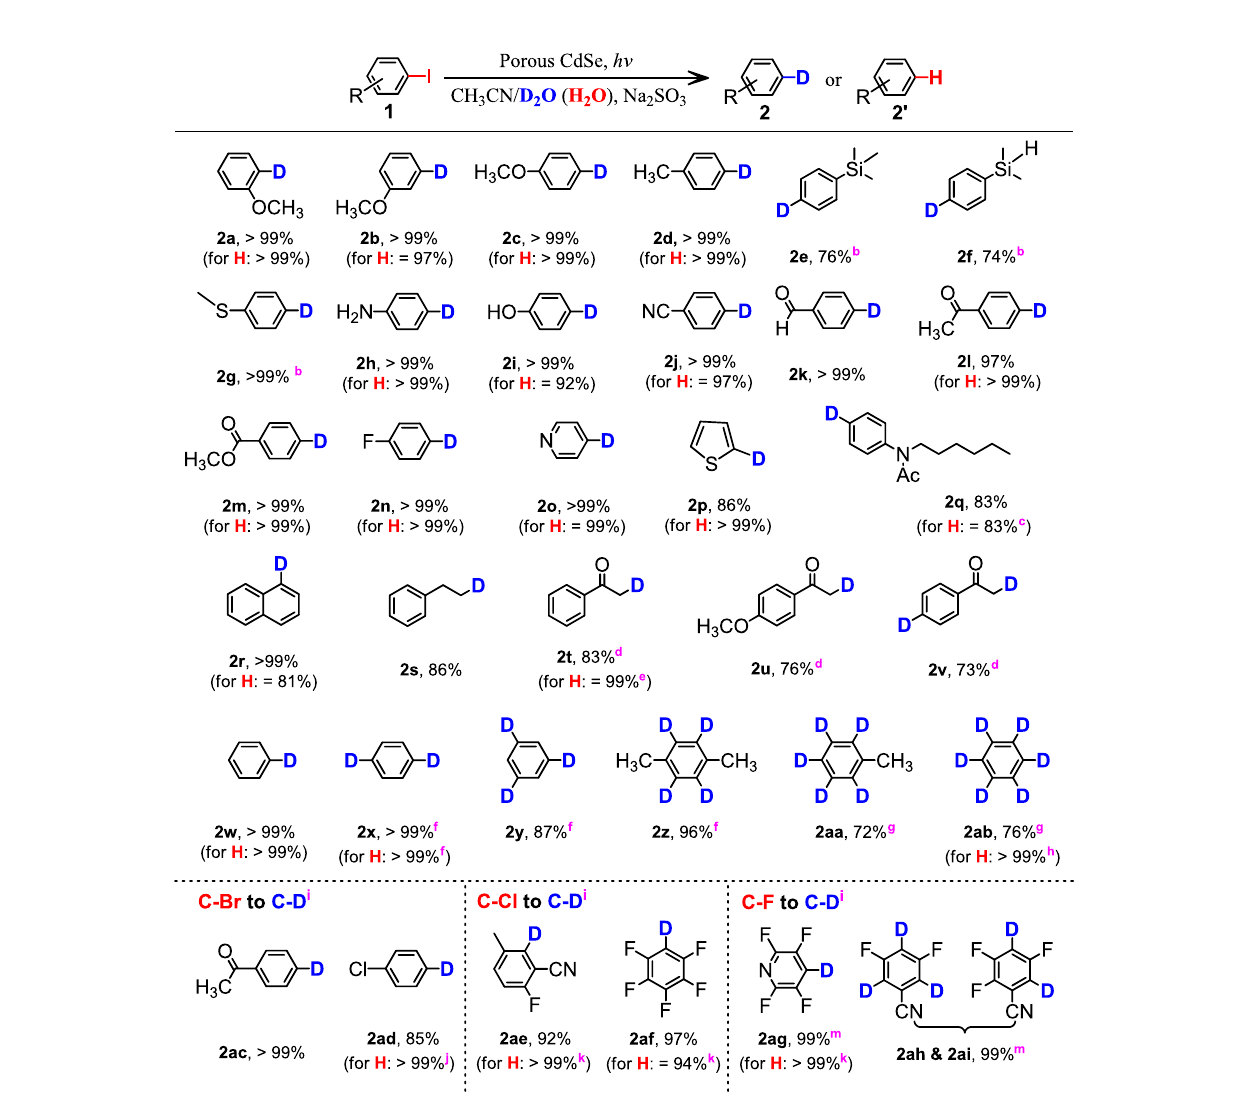
Table 1 Scope of photocatalytic C – X to C – D transformation